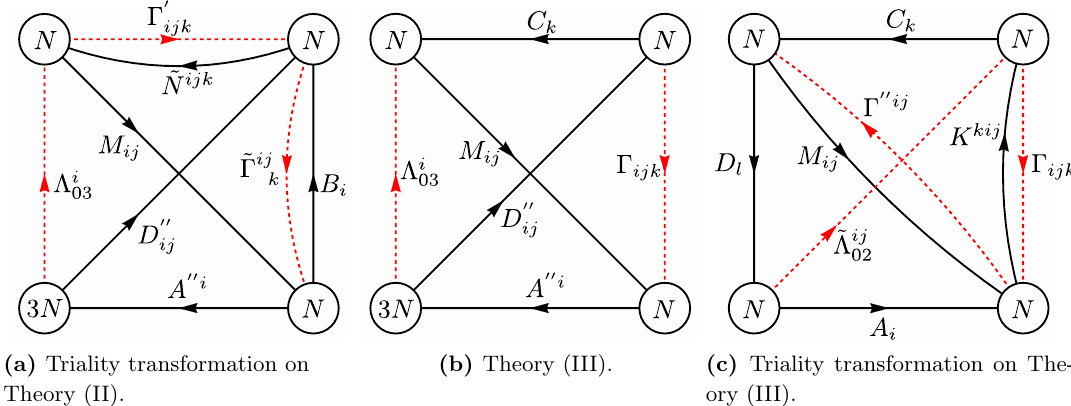
Figure 9 . A triality move on node e 0 of Theory (II) gives the quiver shown on the left. Integrating out the massive (cid:12)elds, we obtain Theory (III), shown in the middle. Another triality move on Theory (III) gives the theory on the right, which is equivalent to Theory